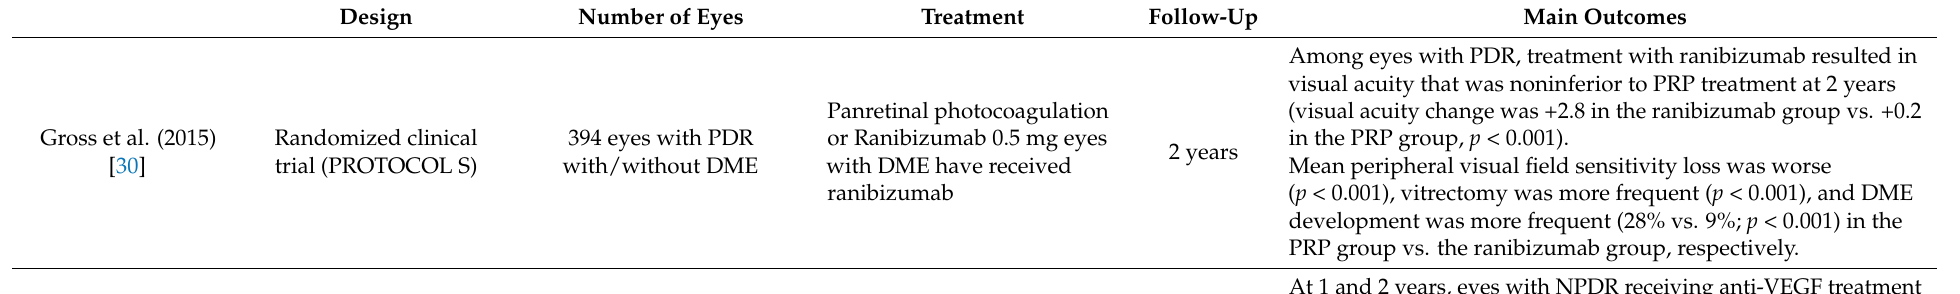
Table 1. Main findings of the studies included in the